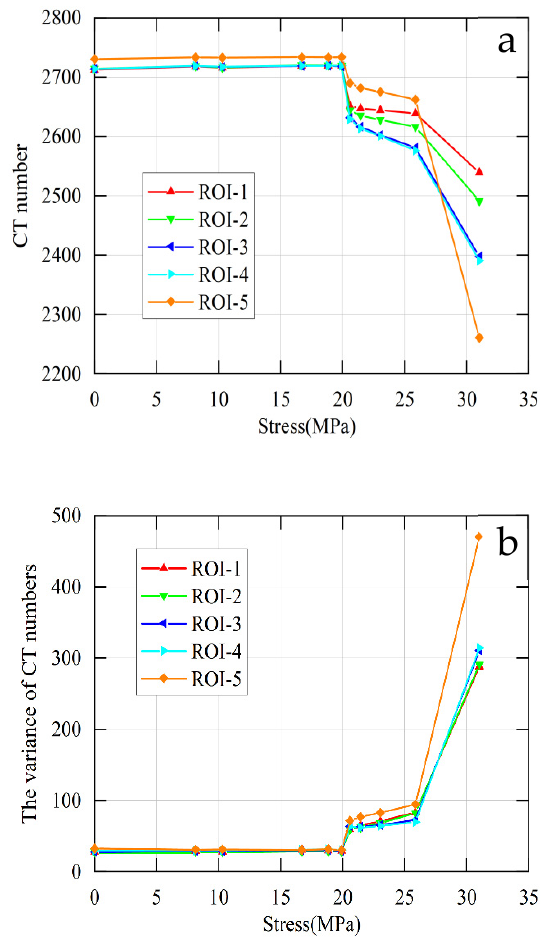
Figure 6. Statistical curve of CT number in ROI with loading process: ( a ) variation curve of CT number in ROI with stress; ( b ) variation curve of the variance in CT numbers in ROI with stress.